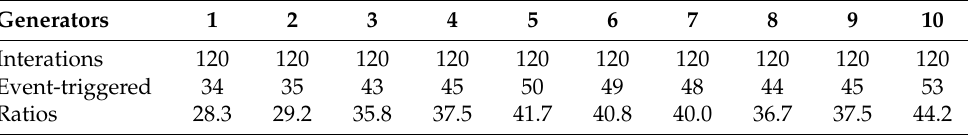
Table 4. Generator event-triggered